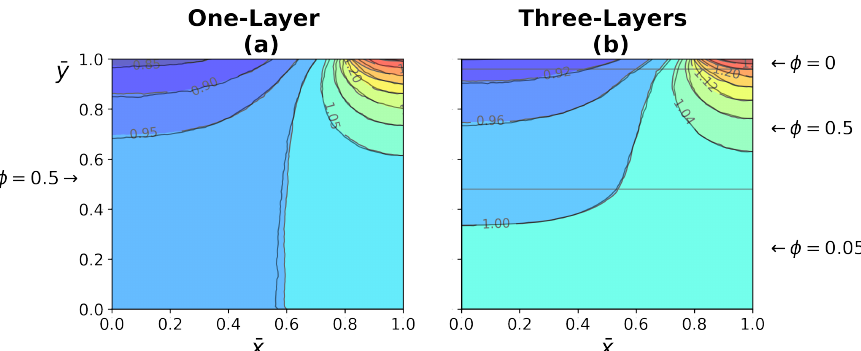
Figure 18. The right half is overlapped on the left half of the temperature distribution for the one- and three-layer tissue. Temperature distribution was taken from Figure 17 at time τ =